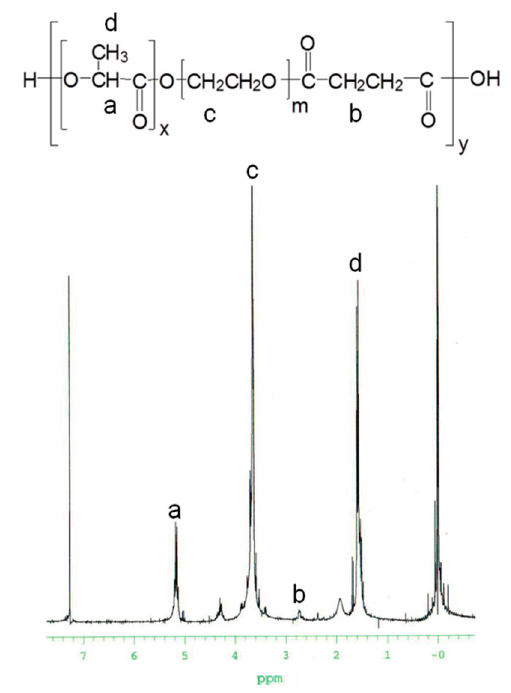
Figure 1. 1 H-NMR spectra of the PLA–PEG multiblock copolymer in CDCl 3 .